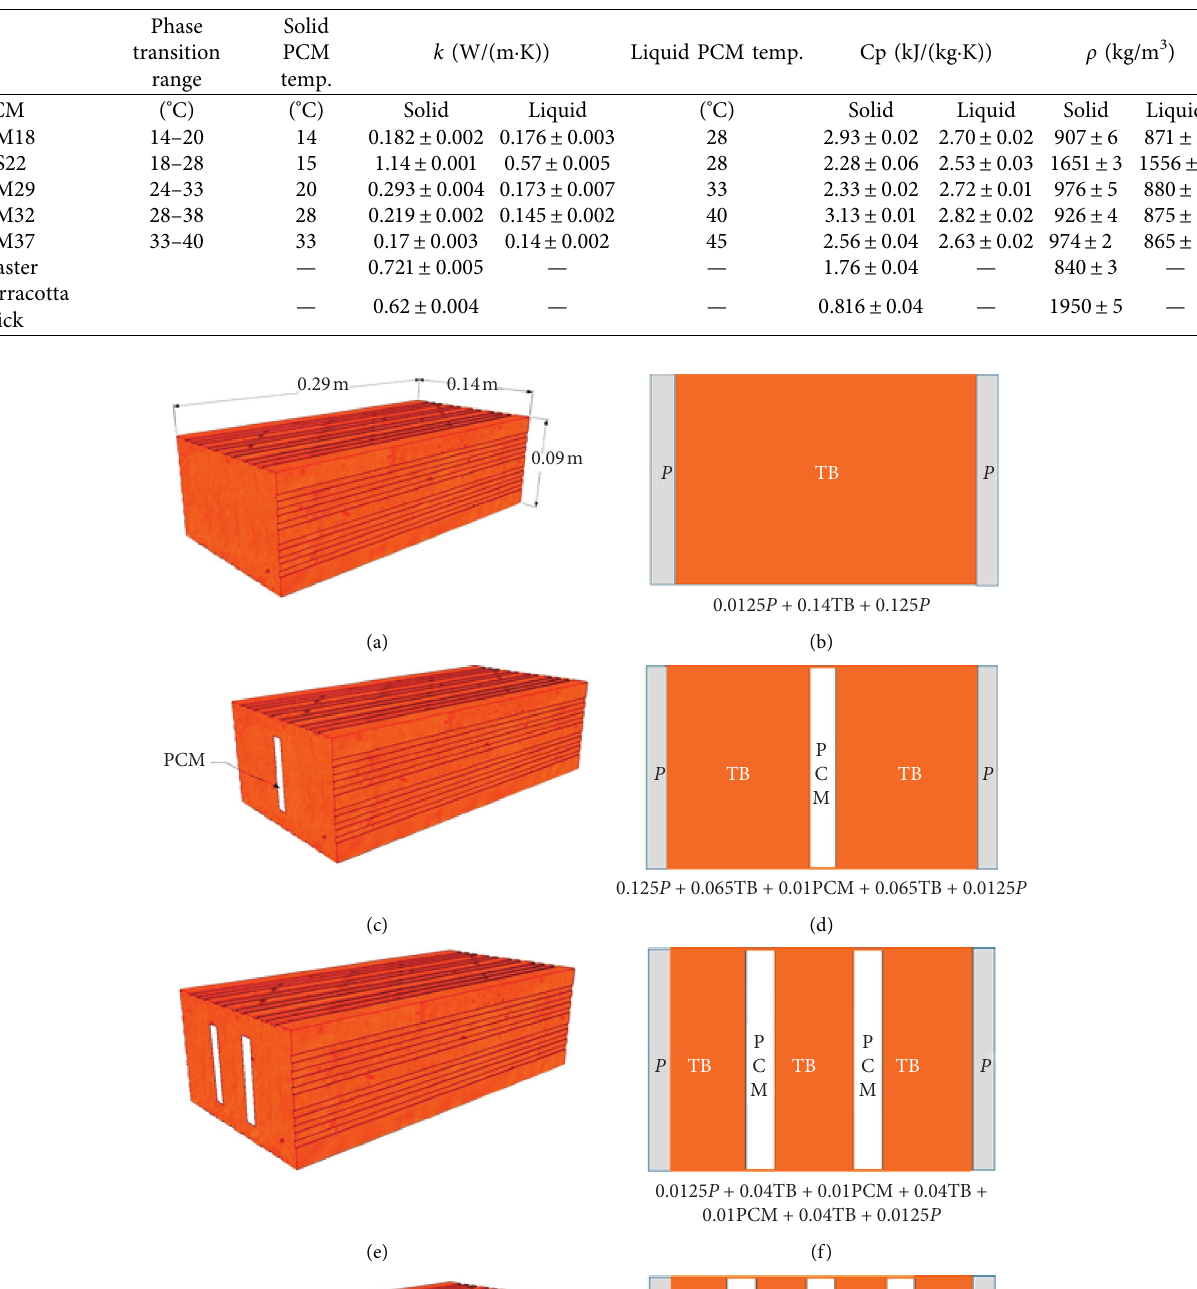
Table 1: Thermophysical properties of studied building materials.